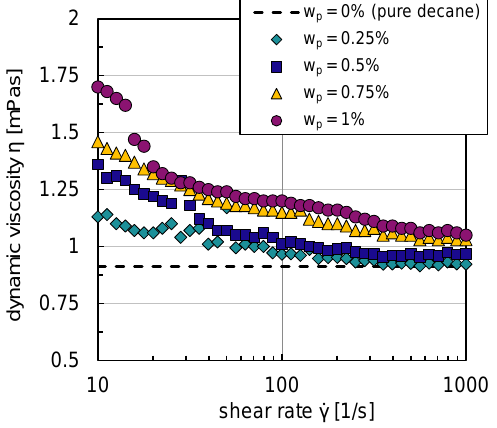
Figure 5. Suspension viscosities with decane as base fluid as a function of shear rate, with different particle mass fractions w p =